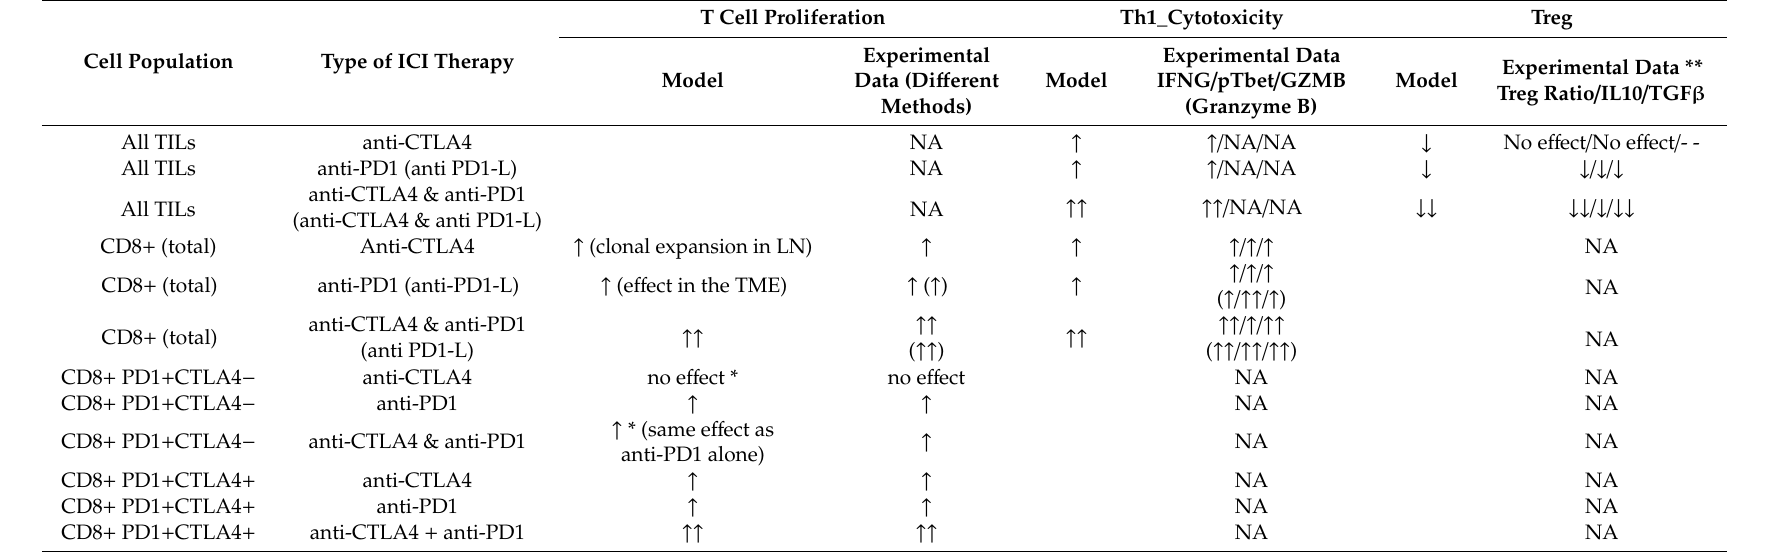
Table 2. Experimental results of anti-CTLA and anti-PD1 treatments in CD8 + cells ( ↑ corresponds to upregulation and ↓ corresponds to downregulation of phenotype after ICI treatment. Note that we refer to the intensity of the response as follows: ↑↑↑ > ↑↑ > ↑ , ↓↓↓ < ↓↓ < ↓ )